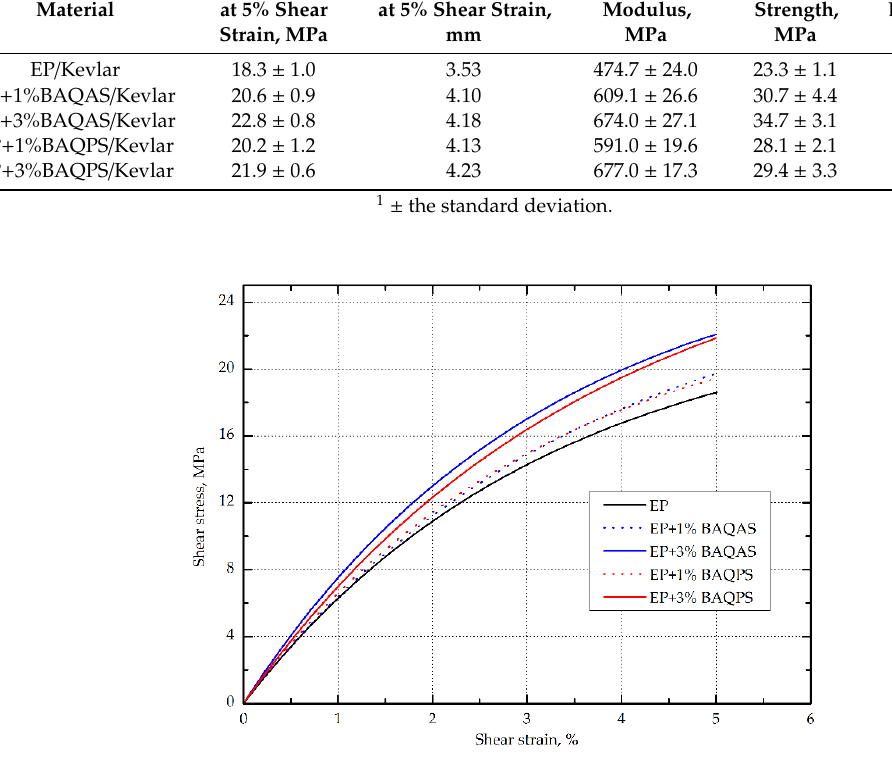
Figure 7. The shear stress vs. shear strain relationship in the range of 0–0.05 of Kevlar-reinforced laminates with EP and EP containing modified bentonite matrices.